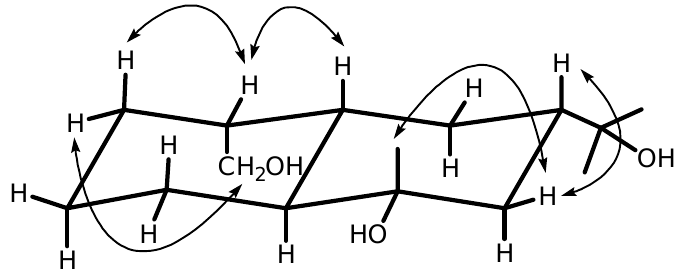
Figure 2. Key NOESY correlations (H → H) of compound 1 .